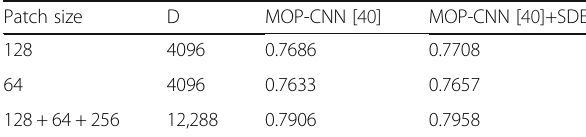
Table 6 Results of MOP-CNN [40]+SDE on Holidays Patch